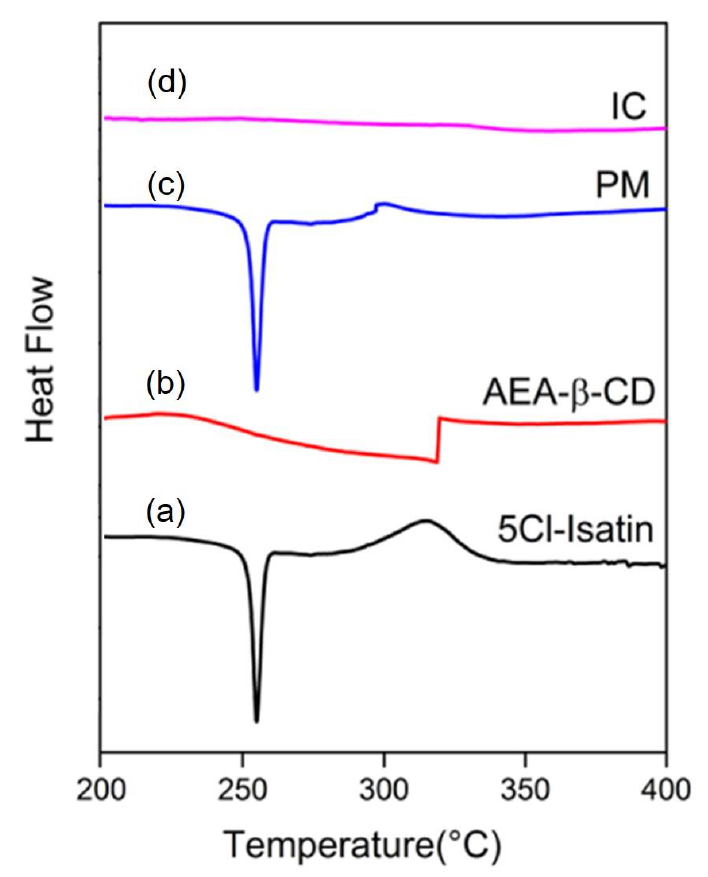
Figure 6. DSC curves of the (a) 5-chloroisatin, (b) AEA- β -CD, (c) their physical mixture, and (d) the inclusion